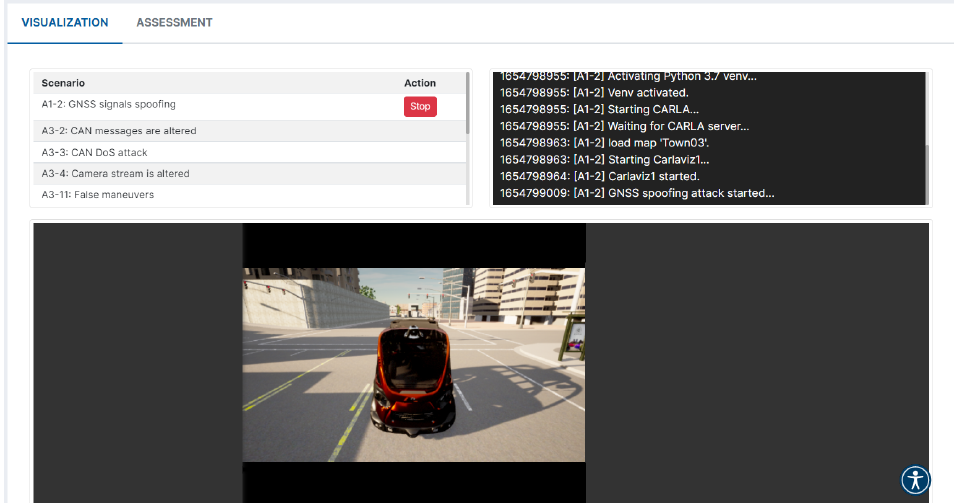
Figure 4. The user interface of the co-simulation tool used for the simulation of the